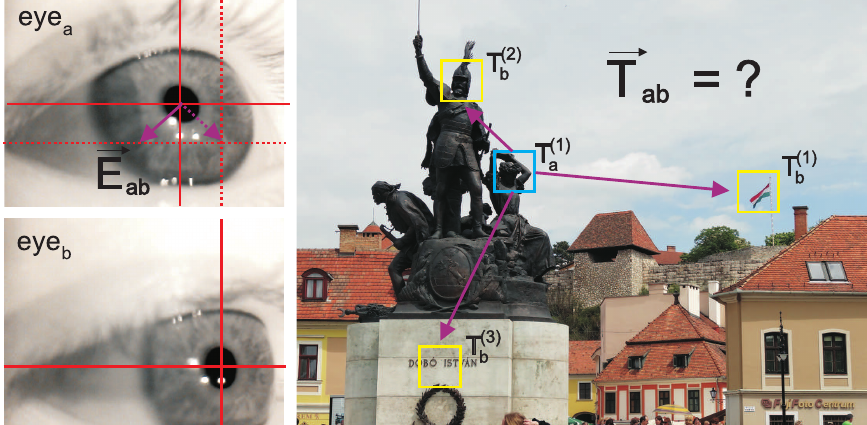
( 1 ) a during fixation a and the eye center was in the point ( 3 ) , because it results in the lowest angle between (cid:126) E ab b